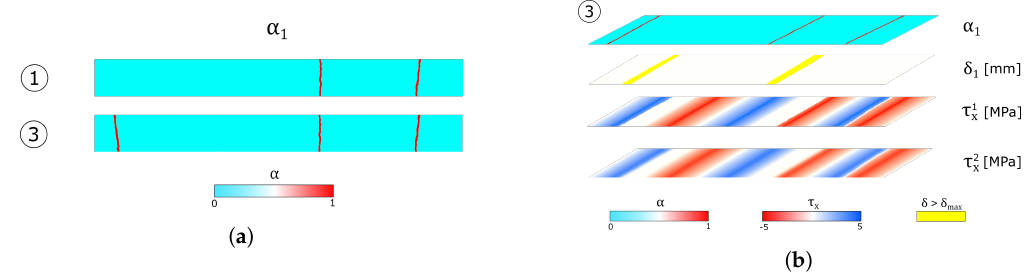
Figure 5. Numerical results of the UD reference test: crack evolution overview. ( a ) Crack pattern in the first layer. ( b ) Exploded view of the composite glass